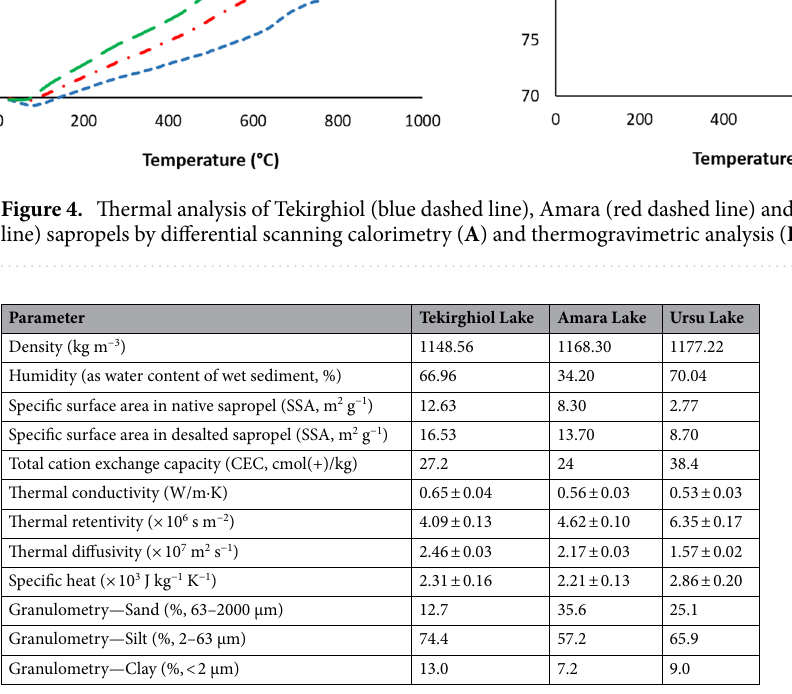
Table 4. Physical and physicochemical properties of saline sapropels collected from Tekirghiol, Amara and Ursu lakes.